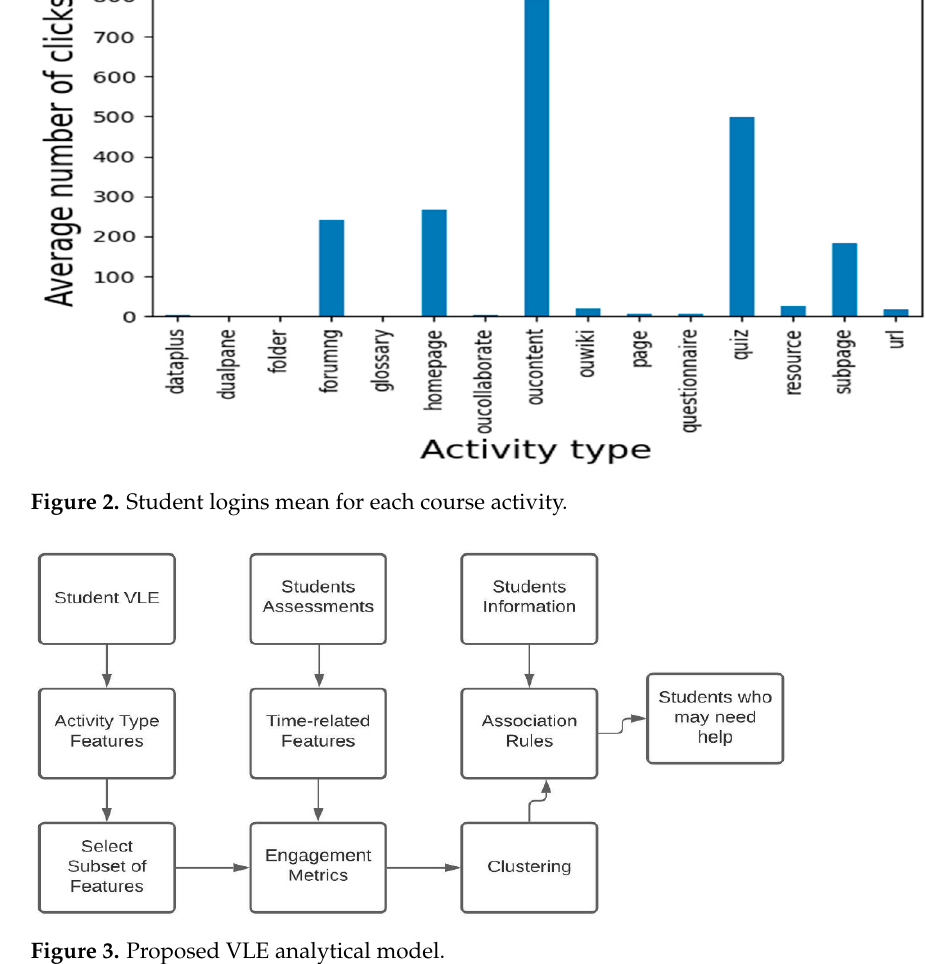
Figure 3. Proposed VLE analytical model.